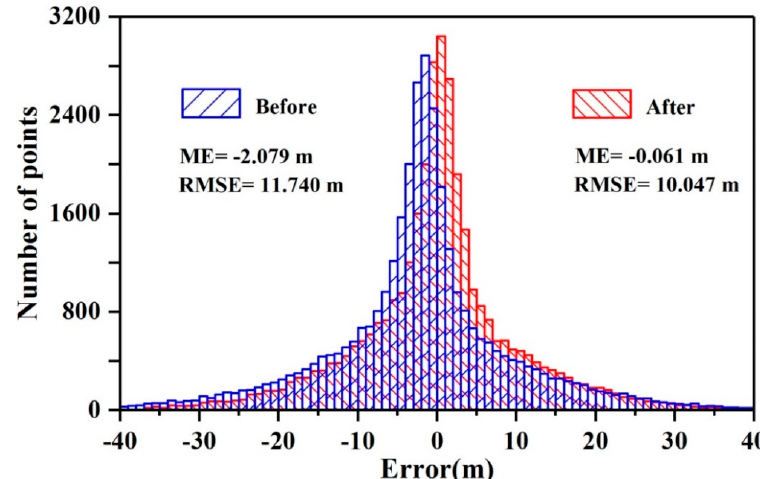
Figure 6. Error histograms of SRTM3 DEM relative to ICESat/GLAS data before and after coregistration.